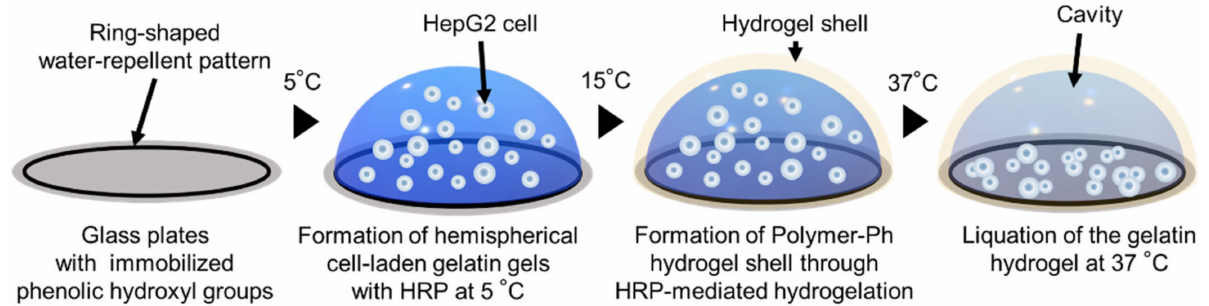
Figure 1. Schematic drawing of Cell Dome preparations on glass plates. Cells are enclosed in a cavity consisting of hemispherical hydrogel